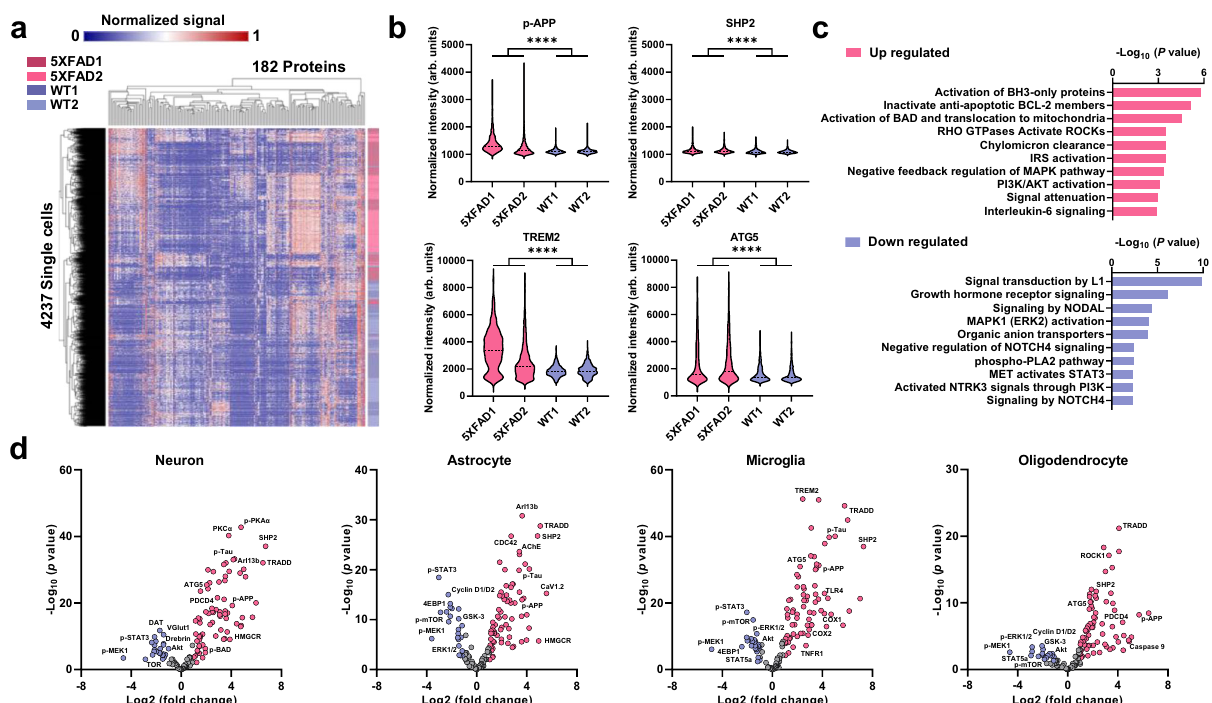
Fig. 4 Comparison of 5XFAD and WT cortical cells through the single-cell CycMIST assay. a Heatmap of unsupervised clustering for both 5XFAD and WT cells. Color bar on the right indicates the distribution of the single 5XFAD cells (red) and single WT cells (purple). The single-cell data above background + 3 × SD are used for clustering by Euclidean distance and complete linkage methods. b Violin plots of 4 representative proteins related with AD development and comparison between 5xFAD and WT cells. ****: p value < 0.0001, determined by two-tailed unpaired T test. The term (arb. units) is abbreviated for arbitrary units. c Gene ontology analysis of upregulated proteins and downregulated proteins in 5XFAD cells when they are compared with WT cells. Pathway enrichment is expressed as − log 10 ( p values) adjusted for multiple comparisons. d Volcano plots of differentially expressed proteins in 5XFAD and WT cells of the subpopulations. Red dots represent proteins expressed at high levels in 5XFAD cells, and purple dots are proteins expressed at high levels in WT cells. Y axis is − log 10 ( p values) while X axis shows log 2 fold change values (two-sided T -test unadjusted p ≤ 0.05 and ≥ 2fold